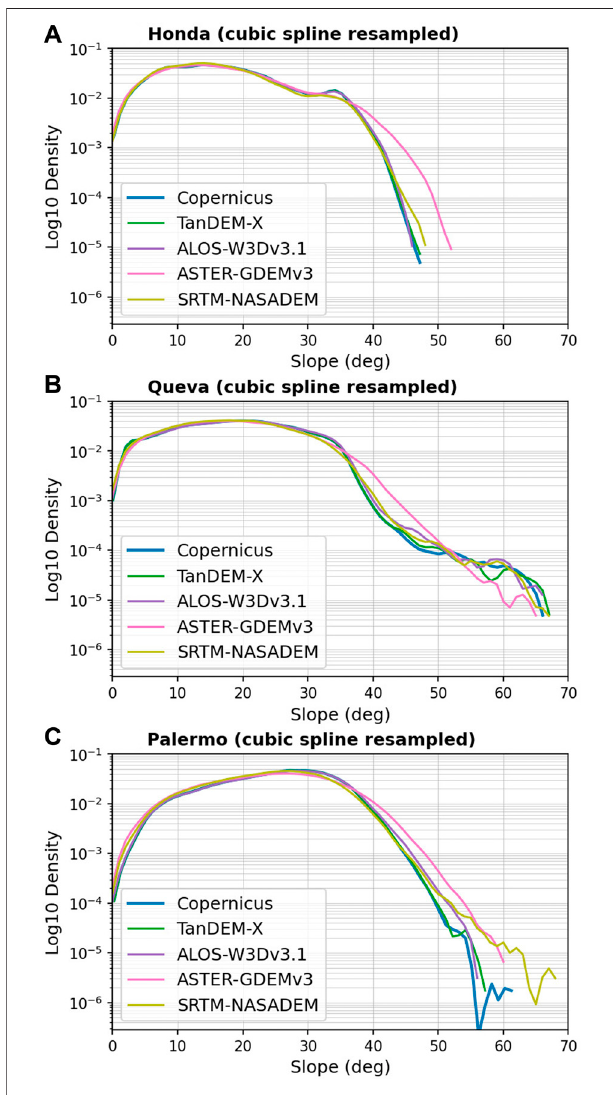
FIGURE 10 | Catchment slope distributions (note the logarithmic y -axes) for each DEM in the three — (A) Honda, (B) Queva, and (C) Palermo — test catchments shown in Figure 1 . Slope was calculated with the Zevenbergen and Thorne (1987) algorithm on cubic spline resampled 30-m DEMs (but results are comparable with other resampling methods). Note that the ASTER-GDEMv3, which has low inter-pixel consistency, tends to higher occurrences at higher slopes since there is greater variability in adjacent